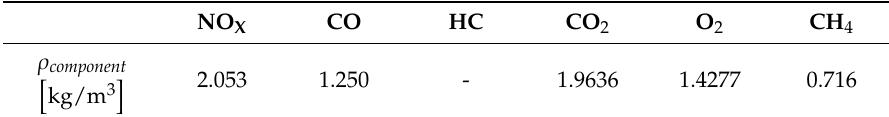
Table 2. Gas component